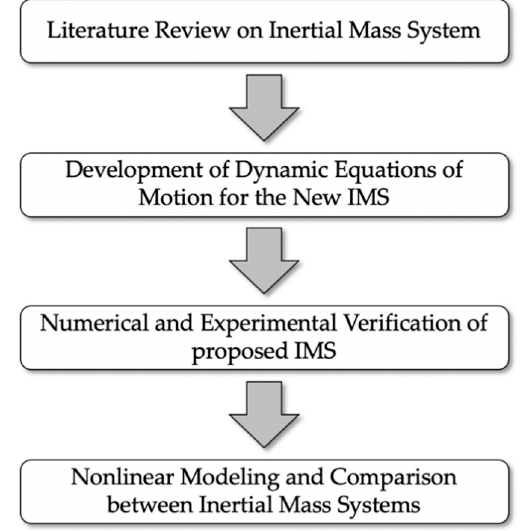
Figure 1. Research